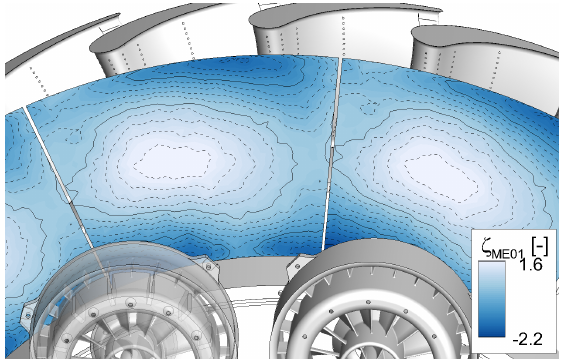
Figure 10. Turbine inlet plane, ME01, passage oriented swirl (SWP) inflow, ζ contour for MFR 3. The flow field downstream of the NGV in ME02 changes significantly. The